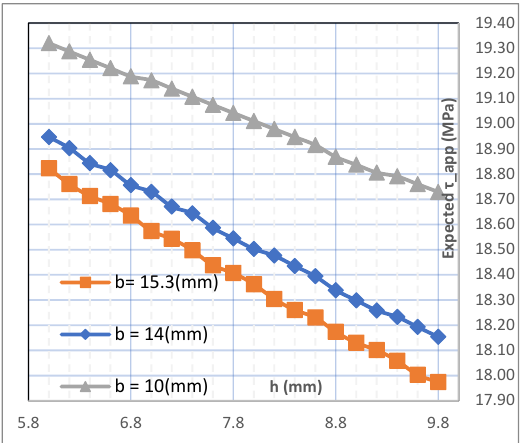
Figure 6. 𝜏 𝑎𝑝𝑝 versus sample height (h) and width (b); Nu = 0.000088. Figure 6. τ app versus sample height (h) and width (b); Nu = 0.000088.